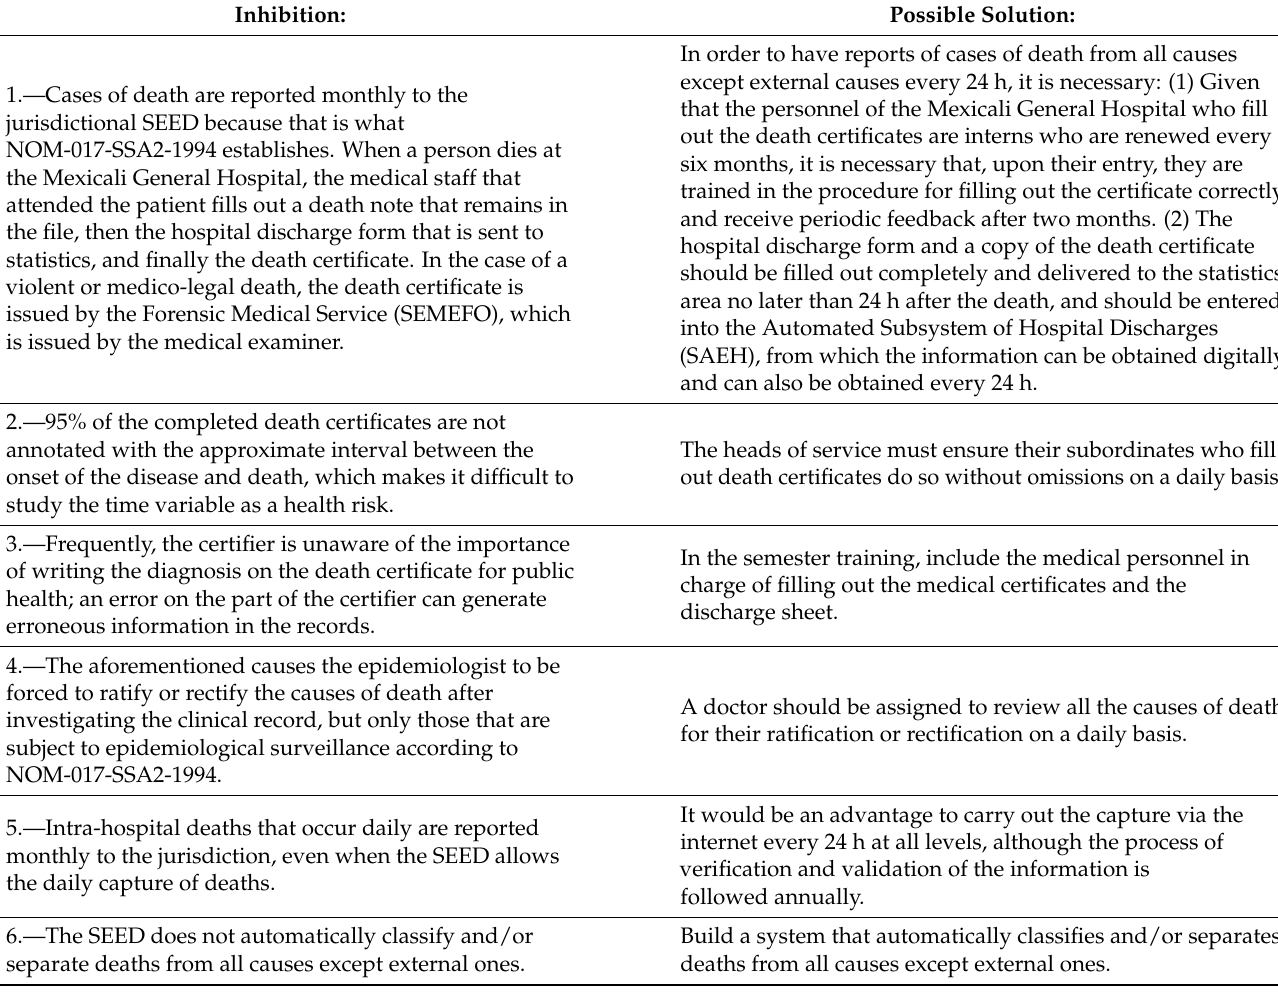
Table 5. Inhibitions and solutions for the daily recording of mortality data for all but external